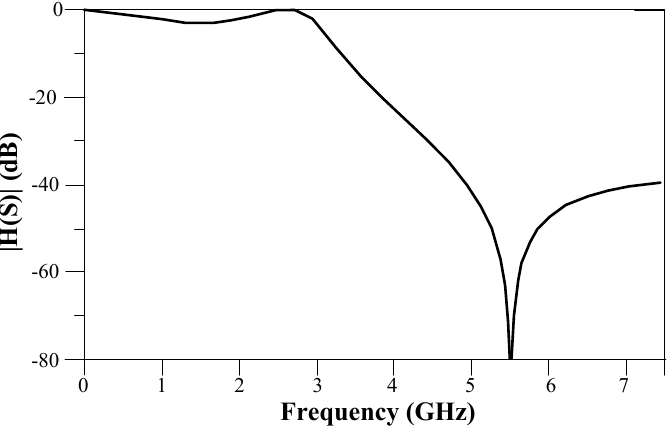
Figure 5. Magnitude of the extracted transfer function H ( S ). After obtaining the LCEC of the initial resonator, the microstrip transmission line realization can be achieved. The layout structure and frequency response of the initial horizontal resonator is depicted in Figure 6a,b.